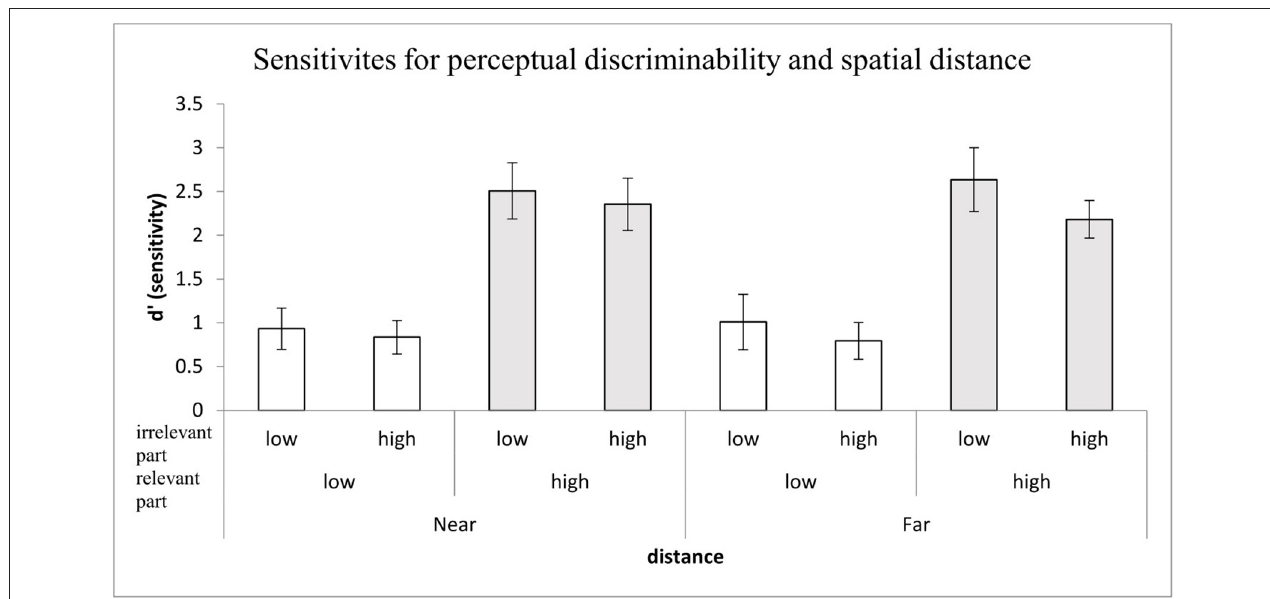
FIGURE 9 | The mean sensitivities collapsed across orientation ( d ’) as a function of perceptual discriminability of the relevant and irrelevant parts. Error bars indicate 95% confidence interval, calculated within